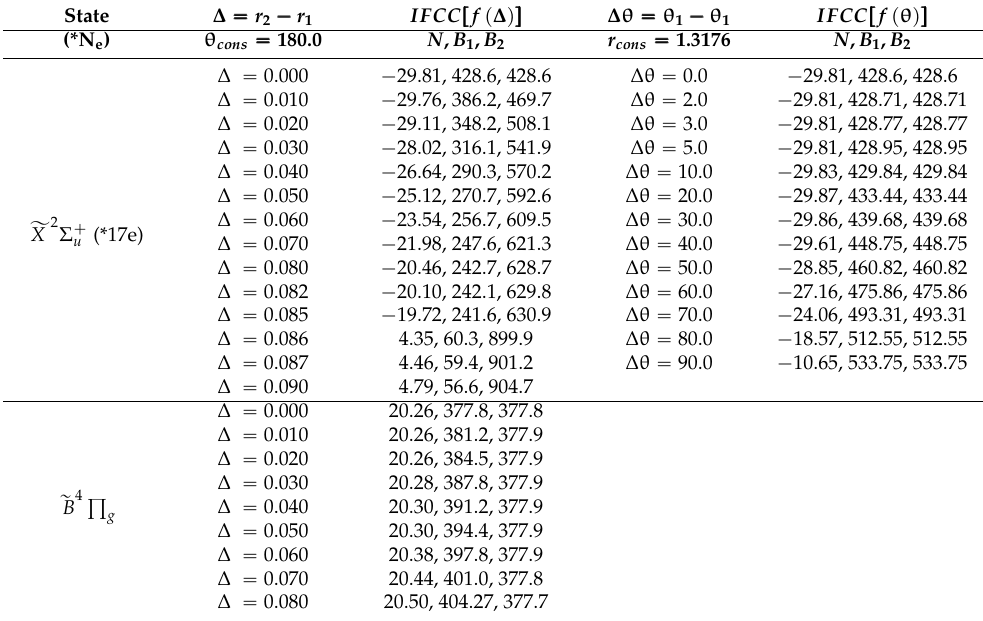
Isotropic Fermi contact coupling (IFCC) of B 2 N p 0 q in ground ( ś r 4 B ( g )